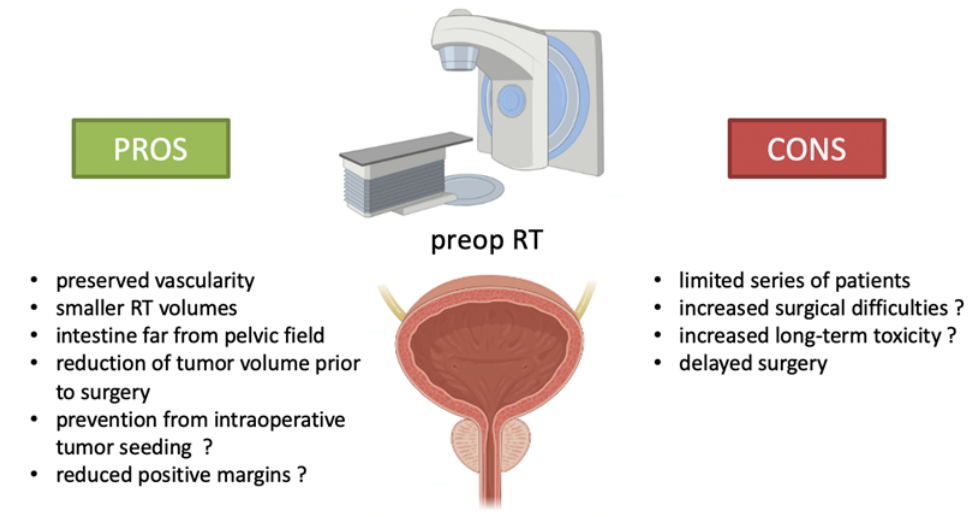
Figure 1. Preoperative RT: pros and